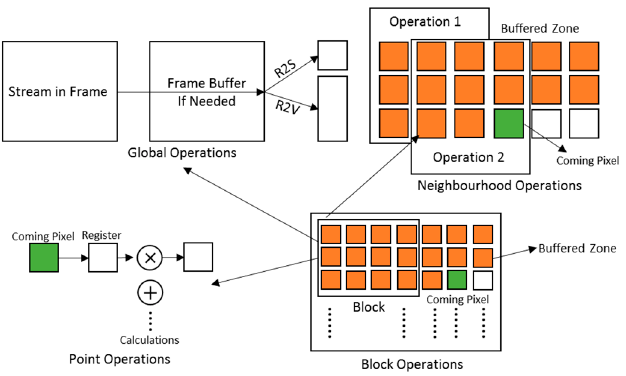
Figure 5. Data flow and buffering for the four different operation types (clockwise: Global, Neigh- borhood, Block and Point operations). hood, Block and Point